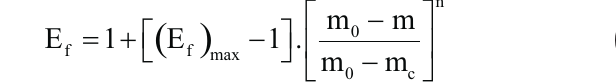
Representation of the one-directional model (Source: Adapted of Anderson et al